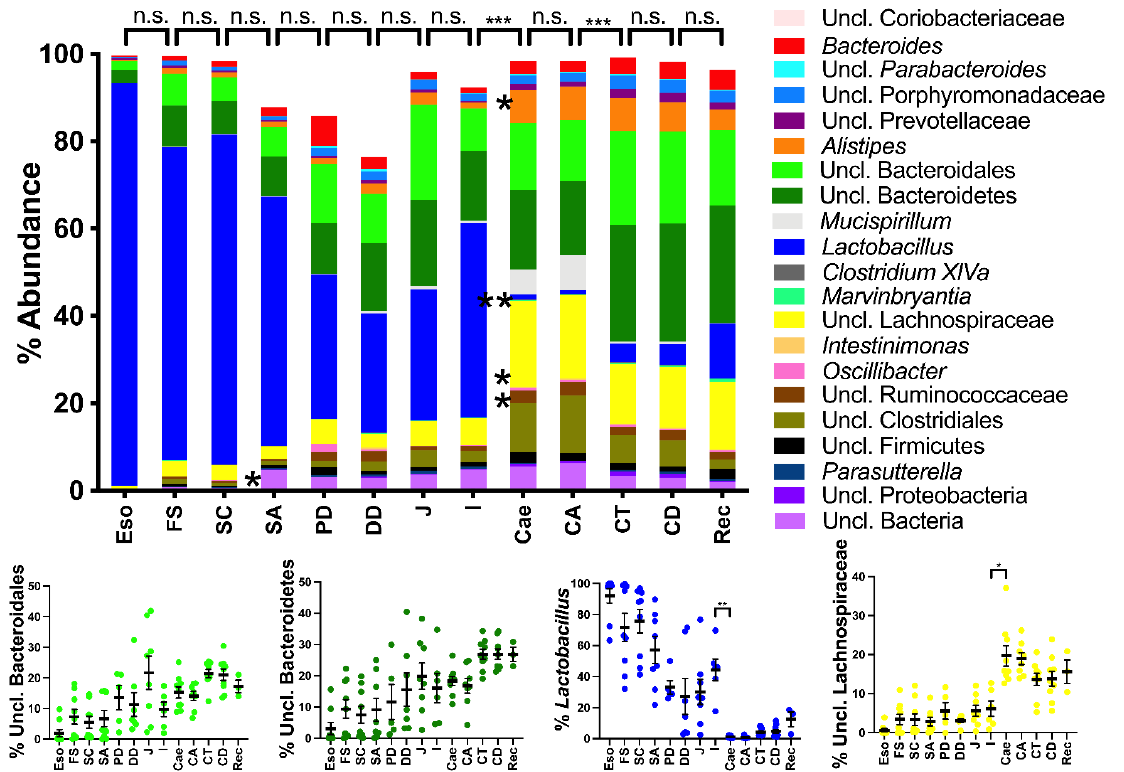
Figure 2. Relative abundance of bacterial microbiota along the alimentary tract of wild-type mice: esophagus (Eso), forestomach (FS), stomach corpus (SC), stomach antrum (SA), proximal duodenum (PD), distal duodenum (DD), jejunum (J), ileum (I), caecum (Cae), ascending colon (CA), transverse colon (CT), descending colon (CD), and rectum (Rec). Top: abundance of taxa detected at least in one region. Pairwise comparison between adjacent regions were calculated with PERMANOVA (n.s., no significant differences; ***, significant differences). Bottom: abundance of taxa belonging to unclassified Bacteroidales (light green), unclassified Bacteroidetes (dark green), Lactobacillus (blue), and unclassified Lachnospiraceae (yellow) detected in the different regions. Differences between taxa in adjacent regions were calculated with Kruskal–Wallis test (Benjamin and Hochberg correction); p < 0.05: *; p < 0.01: **; p < 0.001: